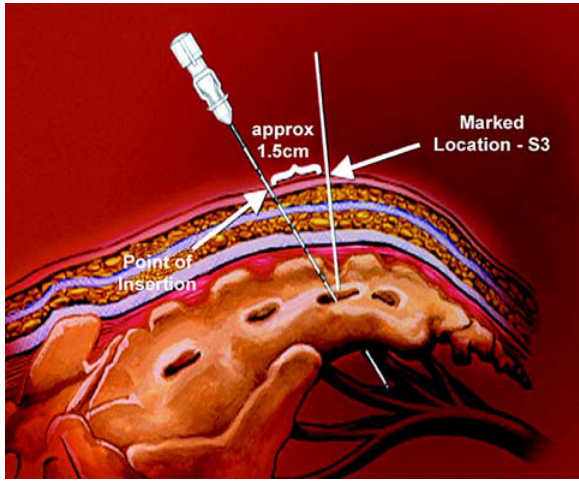
Figure 1 – Localization of S3 foramen by anatomical